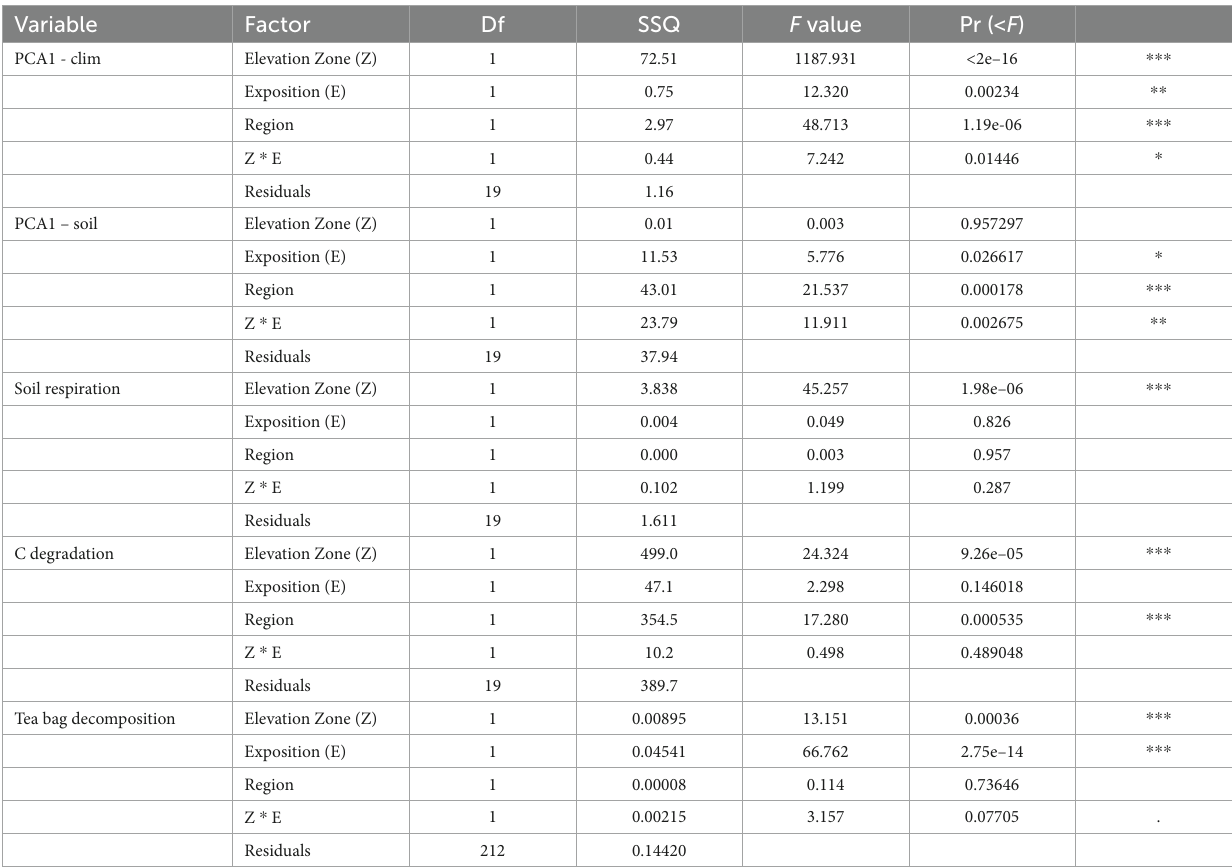
TABLE 1 Two-way ANOVA table for the effect of elevation zone (two levels; alpine and subalpine), exposition (two levels; north and south), region (two levels; Valais, Ticino), and interaction between zone and exposition.